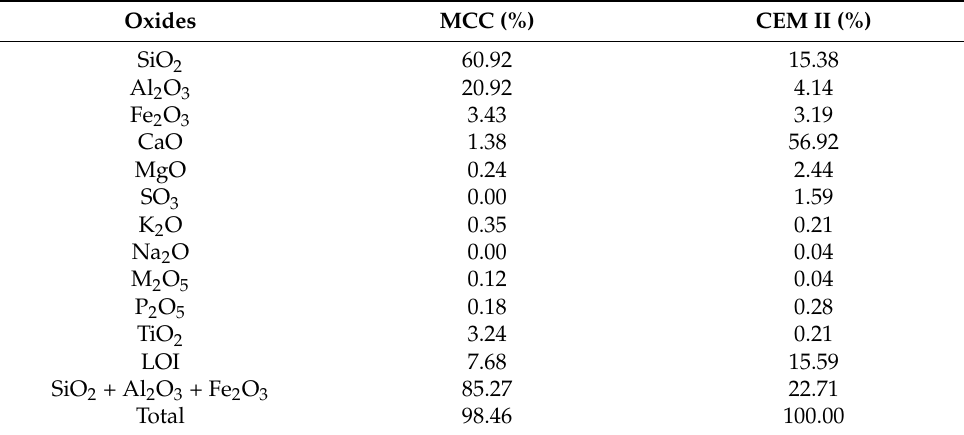
Figure 3. SEM Image of MCC. Table 4. Oxide Composition of Binder